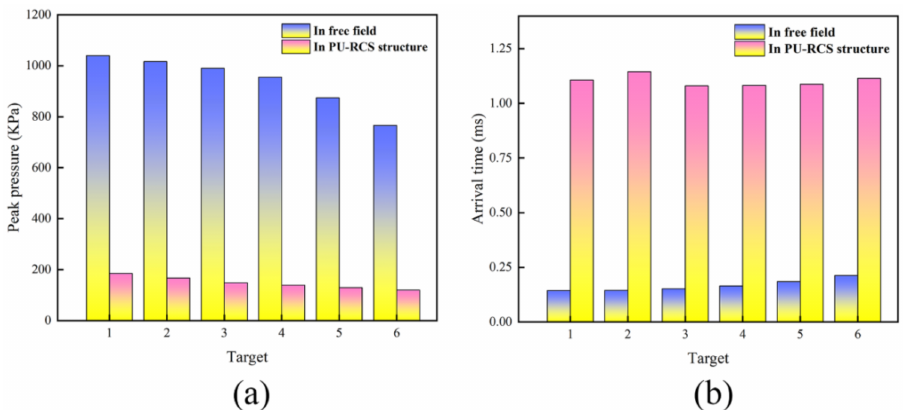
Figure 26. Peak pressure at each target point and its arrival time in CEL model: ( a ) peak pressure at targets; ( b ) arrival time of peak